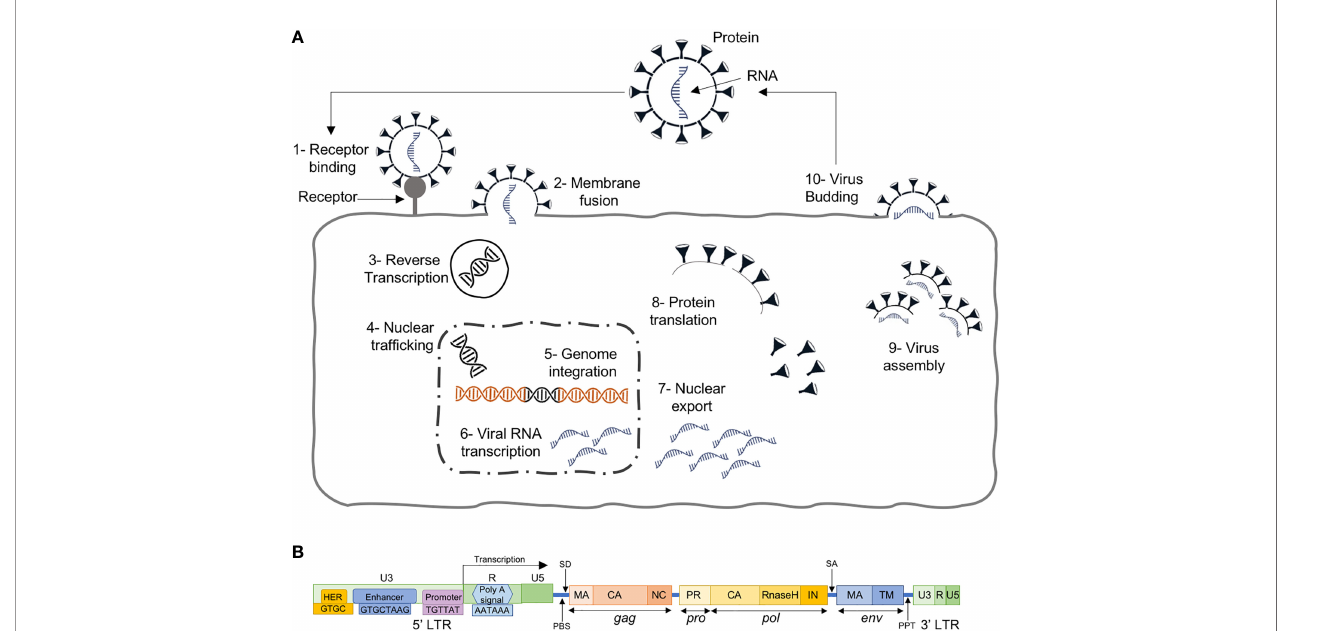
FIGURE 2 | (A) The retroviral replication cycle where, after entry into the host, dimeric single stranded RNA (ssRNA) is reverse transcribed into double-stranded DNA (dsDNA) by virion-associated reverse transcriptase enzyme, which subsequently becomes assembled and matures outside the infected cells, (B) HERV structure with 4 genes ( gag , pro , pol and env ) between the 5 ’ and 3 ’